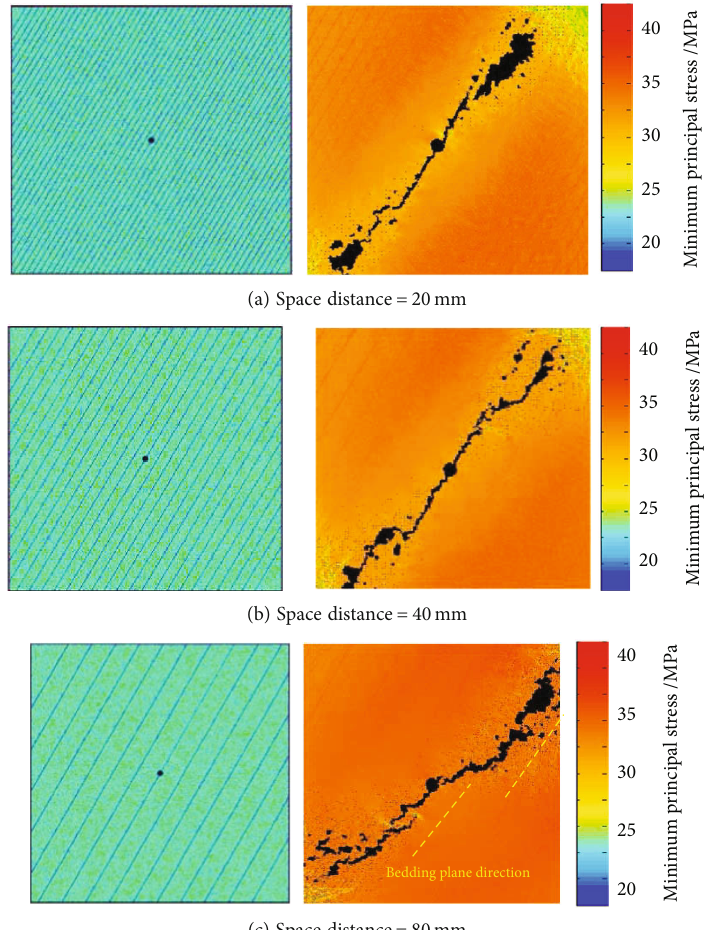
Figure 17: Fracture propagation with di ff erent development densities of bedding plane